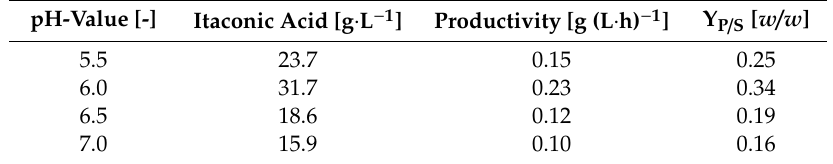
Table 2. Cultivation results of U. rabenhorstiana with pH-control in modified Tabuchi-medium with